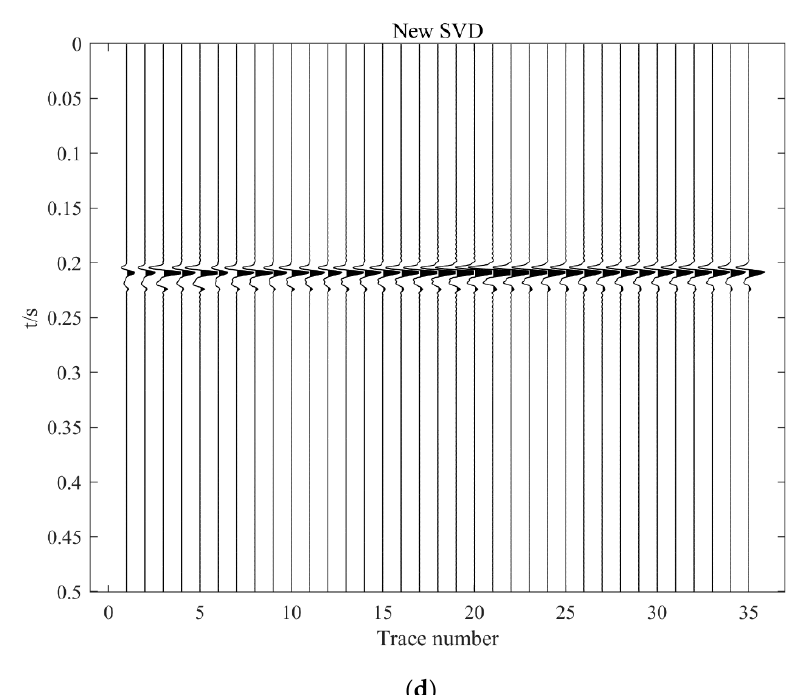
Figure 9. ( a ) Original field seismic data; filtered results achieved using conventional SVD filtering with ( b ) K = 1 and ( c ) K = 2; ( d ) improved SVD filtering.